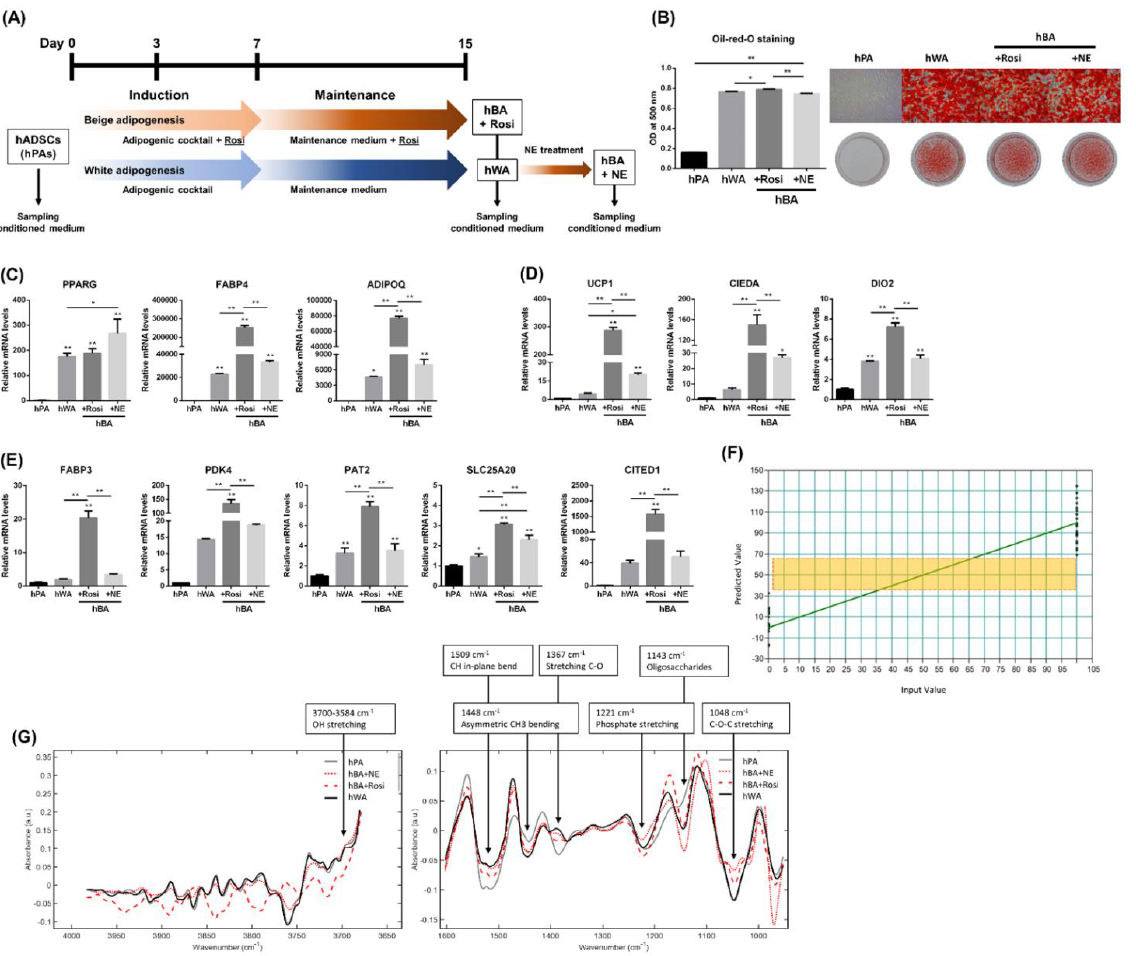
Figure 1. Characteristics of human adipocytes assessed via ORO, expression of human adipogenic/thermogenic markers, and PLSR using FTIR spectra of human adipocytes. ( A ) Schematic images of human adipose-derived stem cell differentiation. ( B ) Characteristics of mature adipocytes assessed with ORO. ( C ) Expression levels of general adipogenic markers in adipocytes determined via qPCR analysis. ( D ) Expression levels of thermogenic markers in adipocytes determined via qPCR analysis. ( E ) Expression levels of beige-specific markers were assayed by qPCR. ( F ) PLSR for hBA and transparent yellow box indicating non-overlapping area. ( G ) Pre-processed spectra used in PLSR for hBA. ORO and qPCR results are shown as mean ± SEM ( n = 3). * p < 0.05; ** p < 0.01 compared to each group.